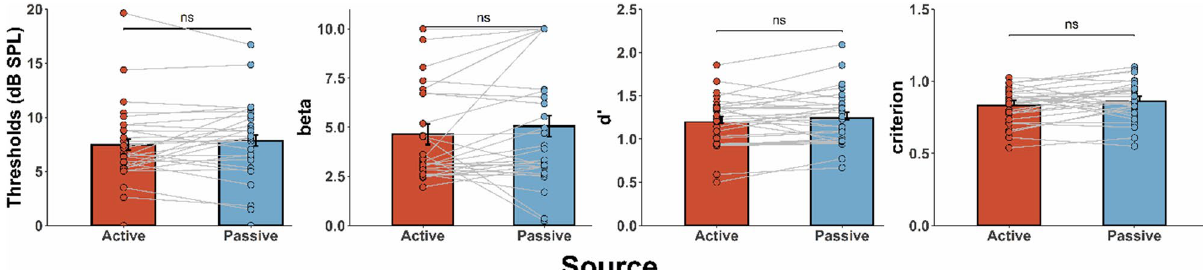
Figure 4. Summary of the results from the detection task. Mean threshold, beta value for slope, d ʹ score, and criterion. Error bars depict within-subjects confidence intervals 80–82 . There were no significant differences between active and passive in the threshold (one-tailed paired samples t-test, p > .050), slope (i.e., beta values from the psychometric fitting procedure; nonparametric Wilcoxon test due to violation of normality assumption, p > .050), d ʹ score (one-tailed paired samples t-test, p > .050), or criterion (two-tailed paired samples t-test, p >